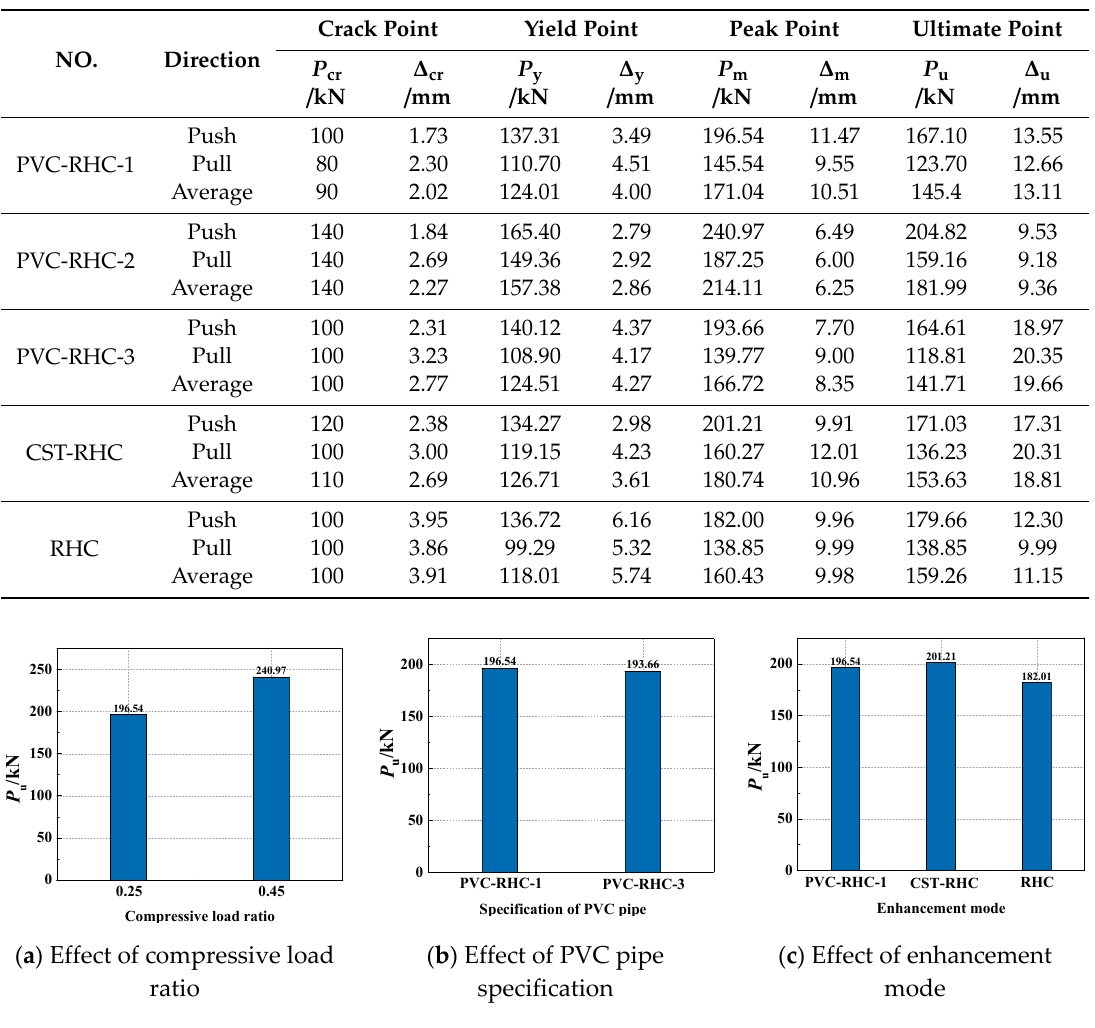
Figure 8. Parametric analysis of bearing capacity. Table 4. Mechanical characteristics of loads and displacements.